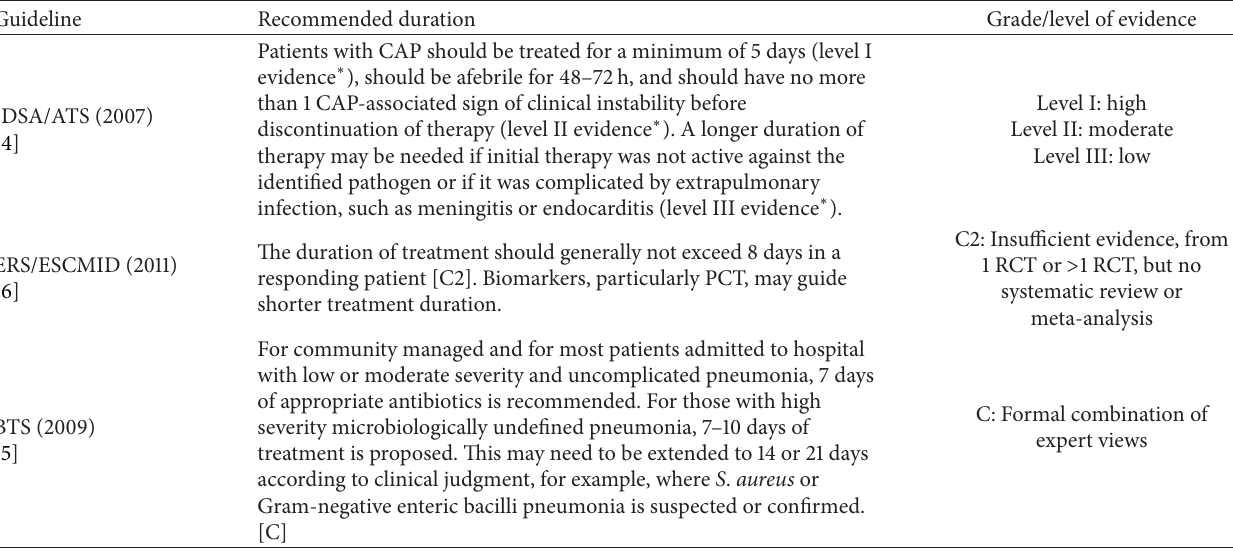
Table 1: This table presents a summary of guidelines recommendations for the duration of antimicrobial treatment of CAP.